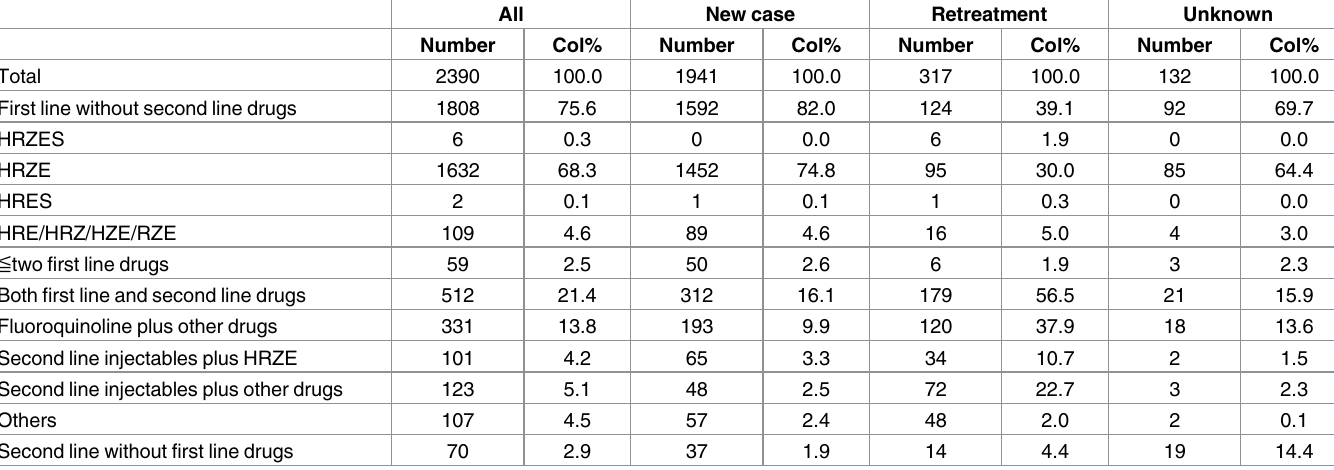
Table 2. Regimens used in the treatment of new and retreatment tuberculosis cases,